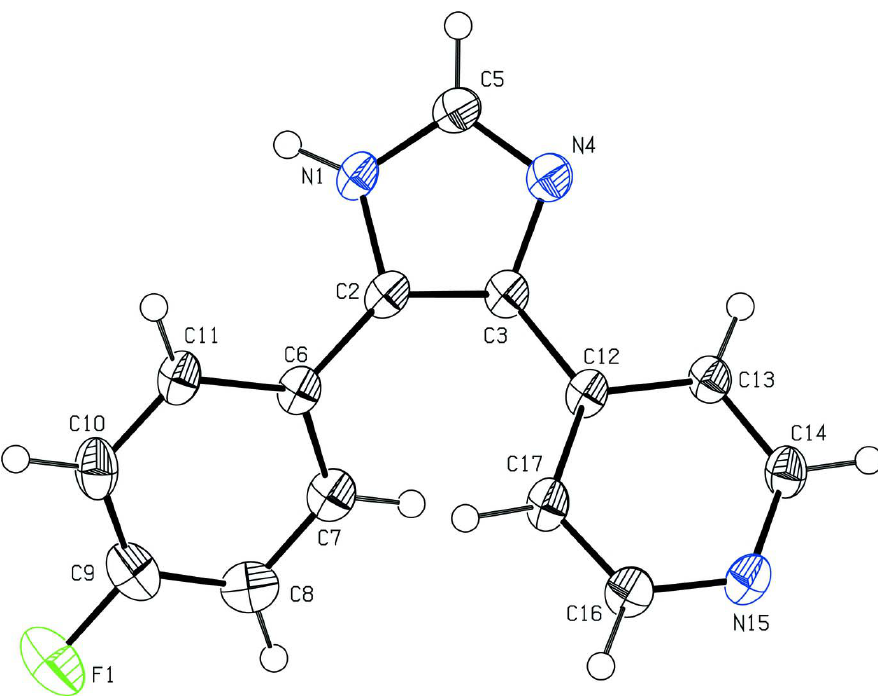
Figure 1 View of compound I . Displacement ellipsoids are drawn at the 50% probability level. H atoms are depicted as circles of arbitrary